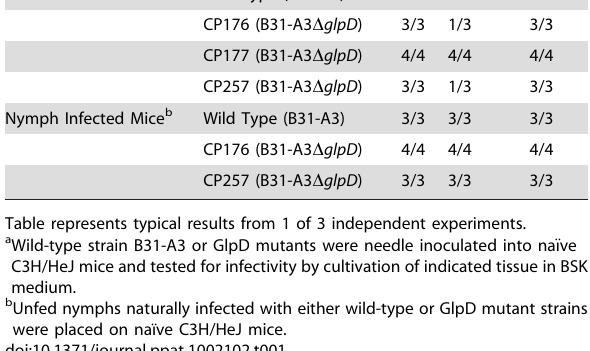
Table 1. Infectivity of B. burgdorferi wild type and GlpD mutants in mice.